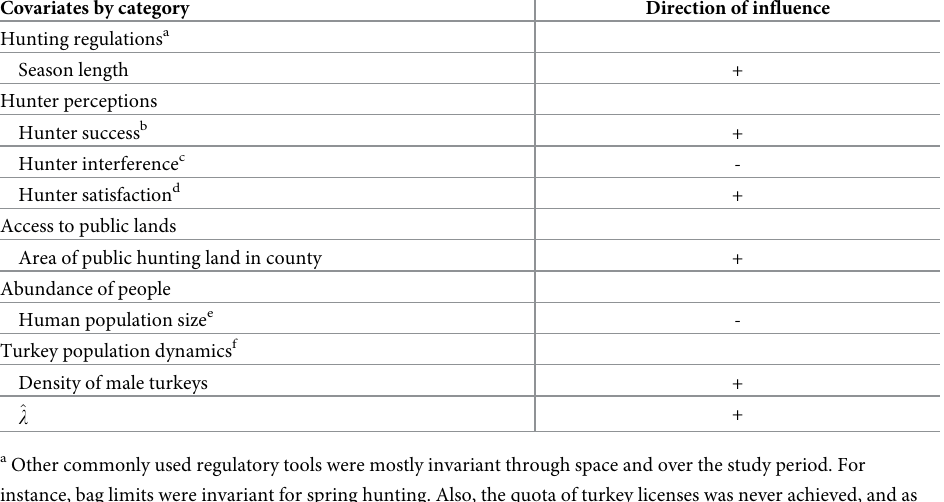
Table 1. Covariates used, and hypothesized direction of influence of each covariate on county-scale wild turkey hunter numbers in southern Michigan, USA, during spring and fall hunting